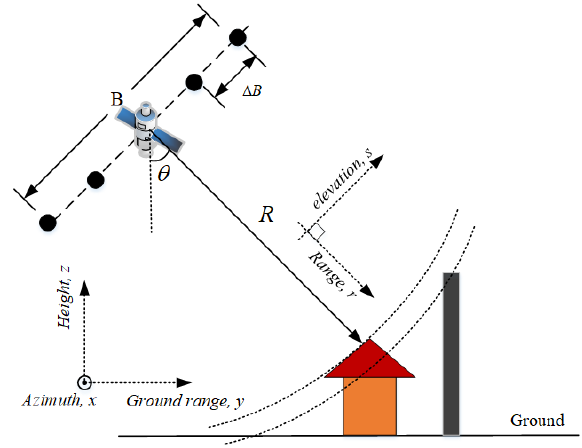
Figure 1. The geometry of the spaceborne TomoSAR imaging system.